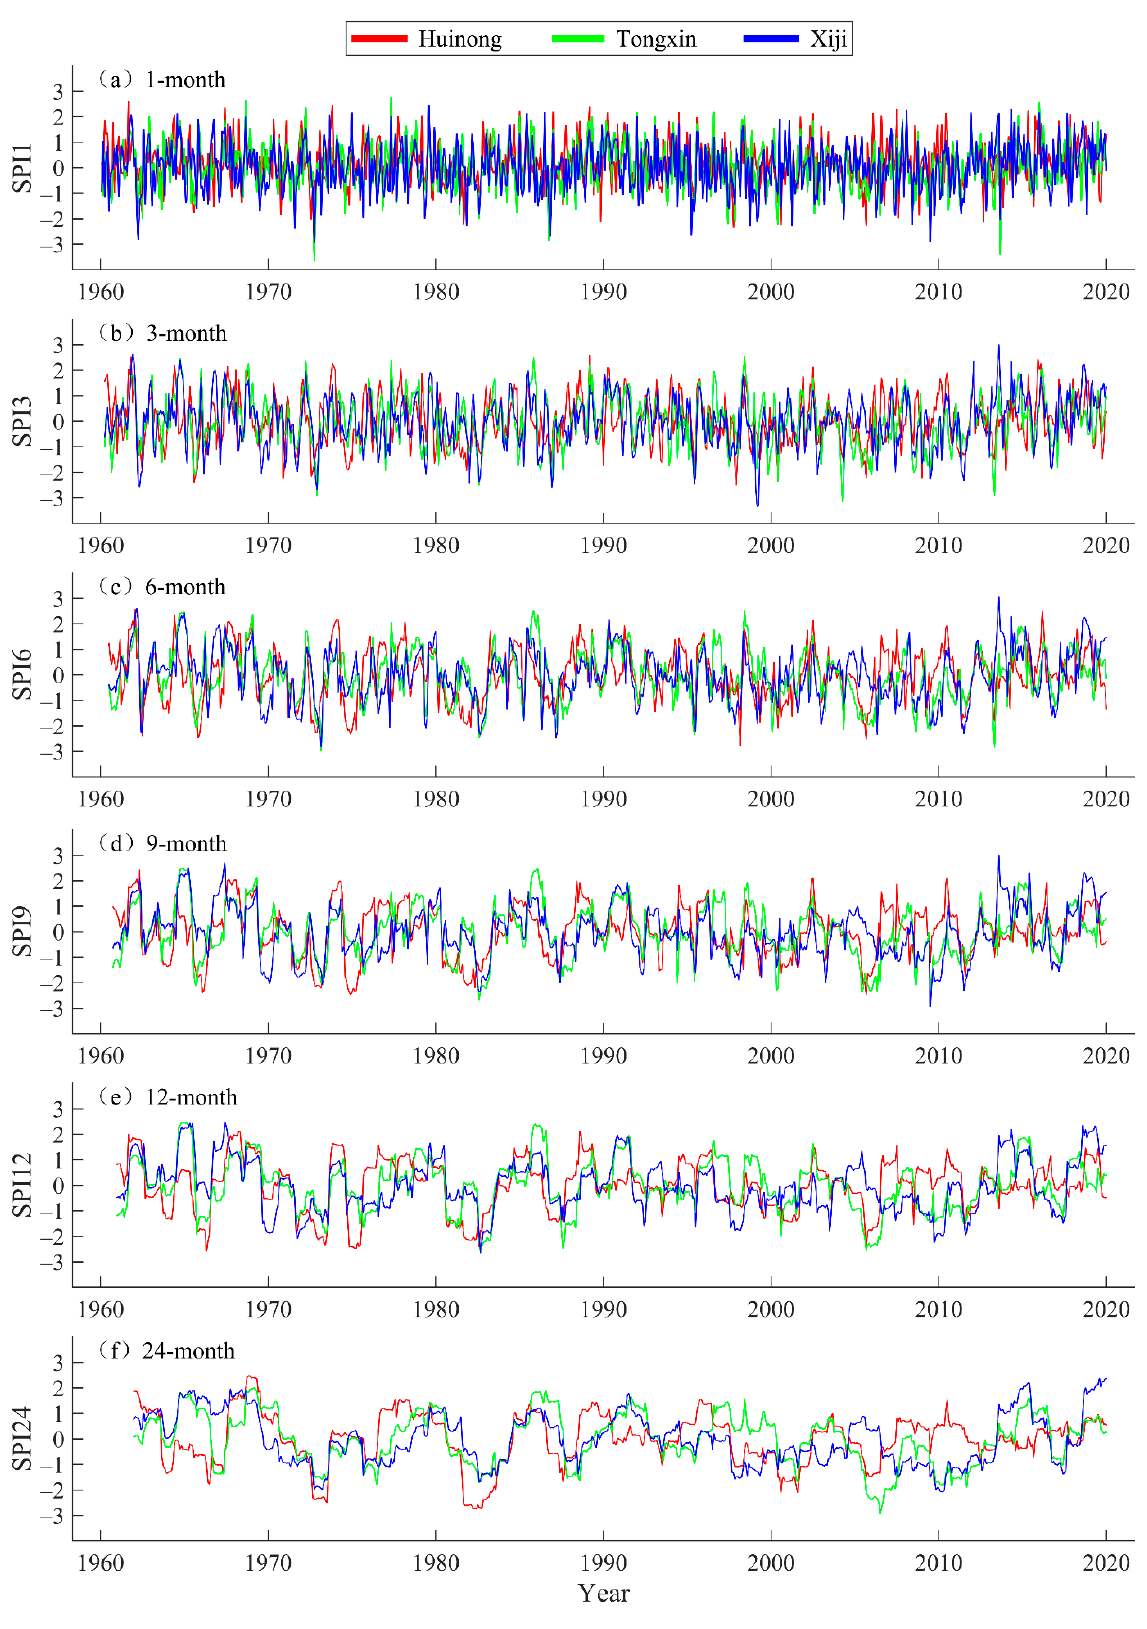
Figure 3. Observed SPI values at different time scales of the example stations.